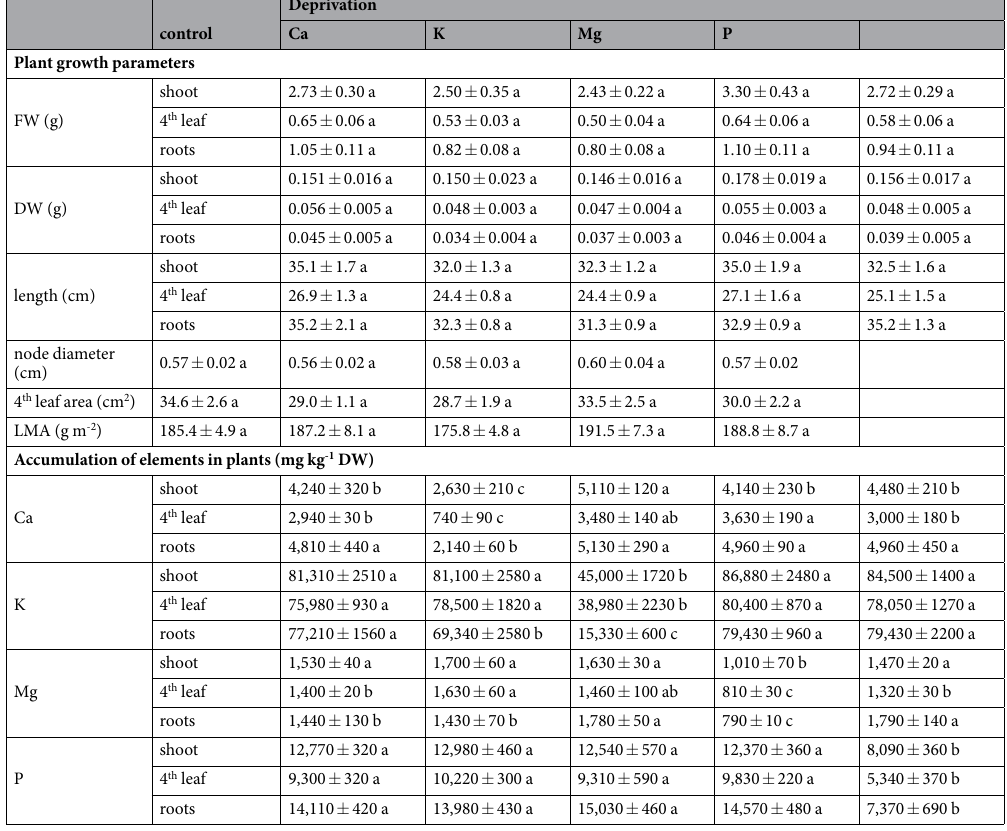
Table 1. Plant growth parameters and accumulation of elements in organs. Presented data are means ± SE (n = 8); Means followed by the same letter in a row are not significantly different from each other using the LSD test (P < 0.05).